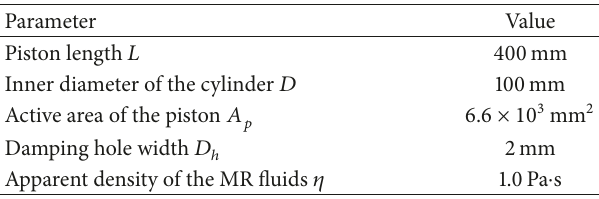
Table 1: Structural parameters of the MR